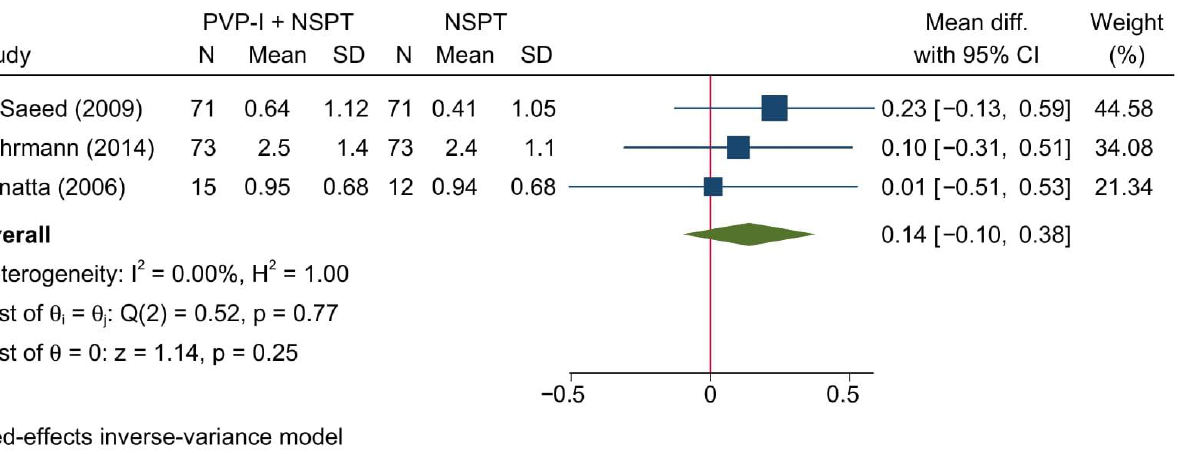
Figure 8. Forest plot showing the comparison between PVP-I + NSPT and NSPT alone regarding gingival recession [34,38,47]. gingival recession [34,38,47].